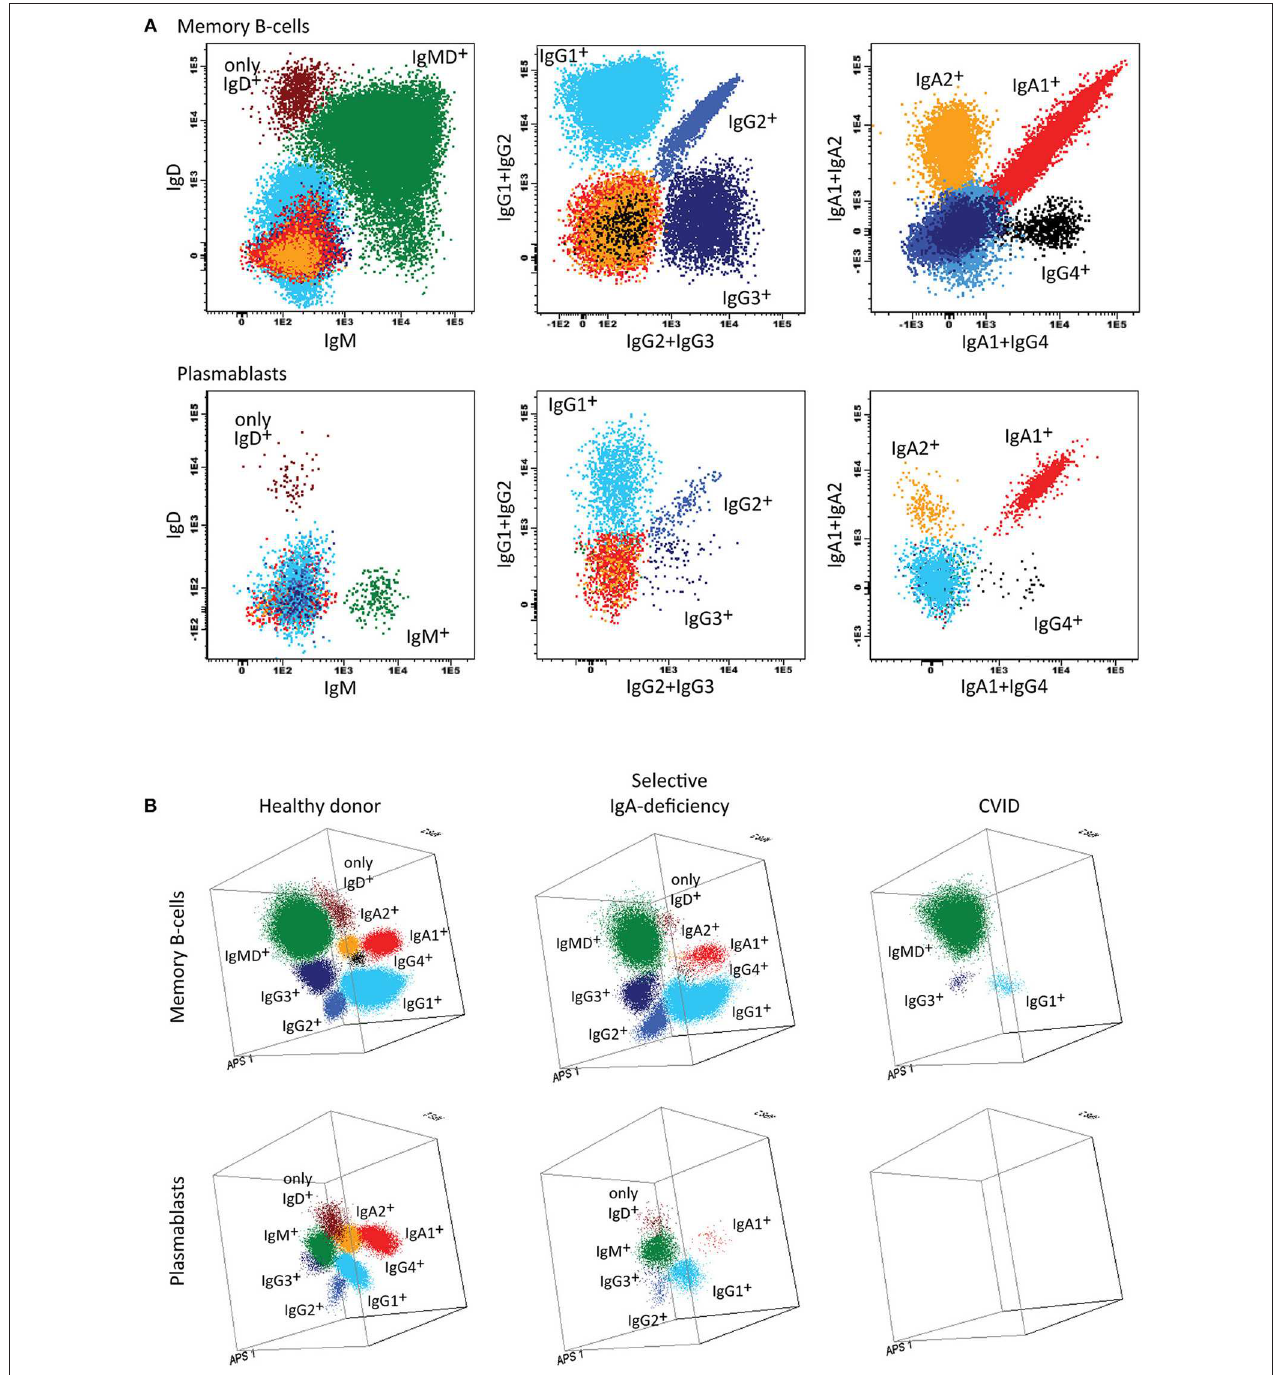
FIGURE 5 | Application of the IgH-isotype tube for the dissection of switched memory B-cells and plasmablasts in blood from healthy donors and PID patients. (A) Bivariate plots showing the distribution of switched memory B-cells (smIgMD − CD19 + CD38 − ) and plasmablasts (CD19 + CD27 ++ CD38 +++ ) according to the surface membrane expression of the different IgH-isotypes (IgG1, IgG2, IgG3, IgG4, IgA1, and IgA2) in 5 × 10 6 peripheral blood leukocytes analyzed with the IgH-isotype tubes in samples from a healthy adult. (B) Three dimensional PCA representation of IgH-isotype subsets in memory B-cells (top) and plasmablasts (lower) in a healthy adult donor (left), a selective IgA-deficient patient (middle), and a CVID patient (right). No plasmablasts were detected in blood from the CVID patient (count of < 0.01 cells/ µ L blood), while variable defects were detected in the memory B-cell compartment, particularly involving switched memory B-cells. The defects in the IgA-deficient patient mainly concerned the IgA-class-switched